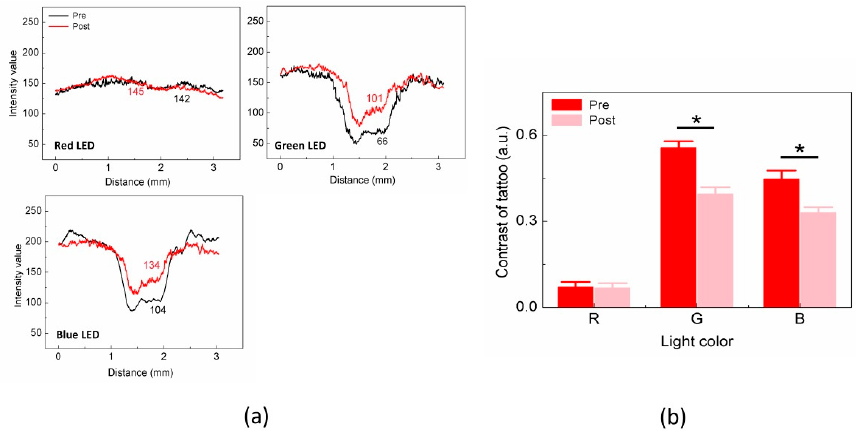
Figure 4. Comparison of red tattoo from pre and post treatment under three LED colors: ( a ) intensity value and ( b ) contrast (N = 10; * p < 0.01).